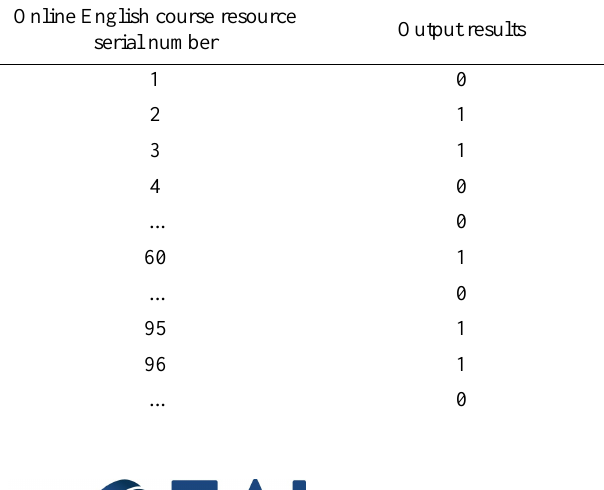
Table 2. recommended results of unit test